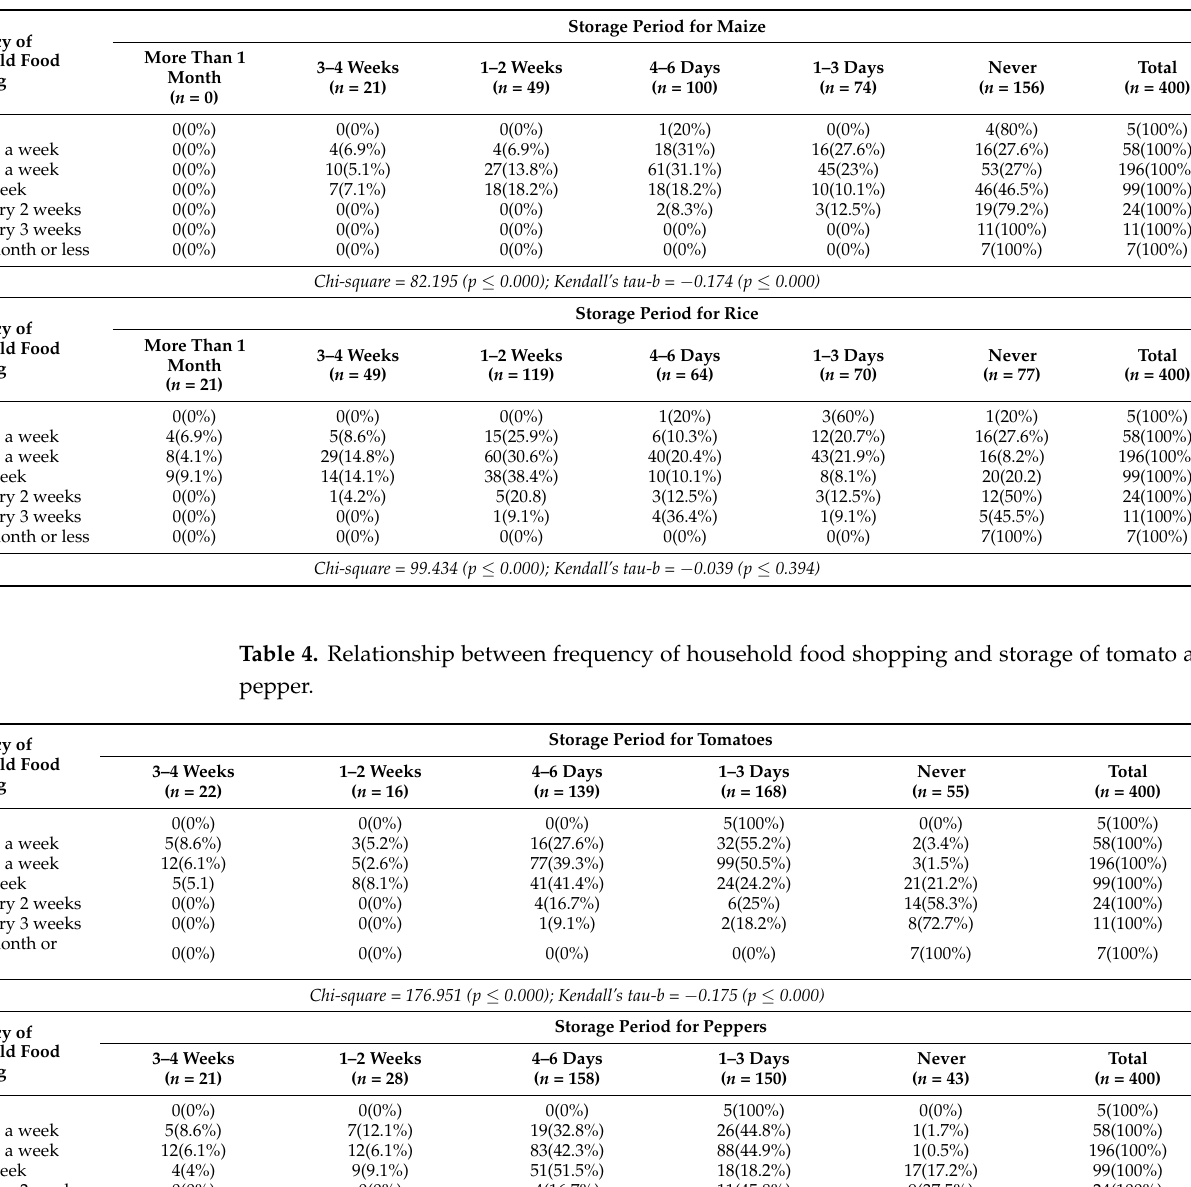
Table 3. Relationship between frequency of household food shopping and storage of maize and rice.